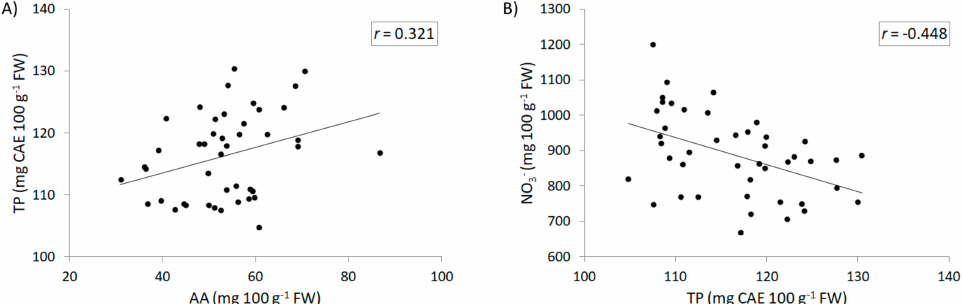
Figure 4. Correlation between nutritional parameters. ( A ) The correlation between the content in ascorbic acid (AA) and total phenolics (TP). ( B ) The correlation between total phenolics (TP) and the content in nitrates (NO 3 −